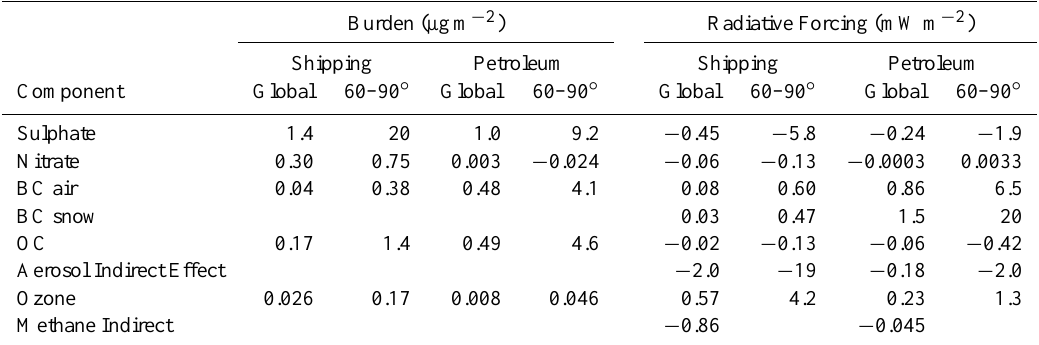
Table 2. Global annual mean atmospheric column [µgm − 2 ] (for O 3 : [DU]) and radiative forcing [mWm − 2 ] from ship and petroleum activity in 2004. Burden (µgm − 2